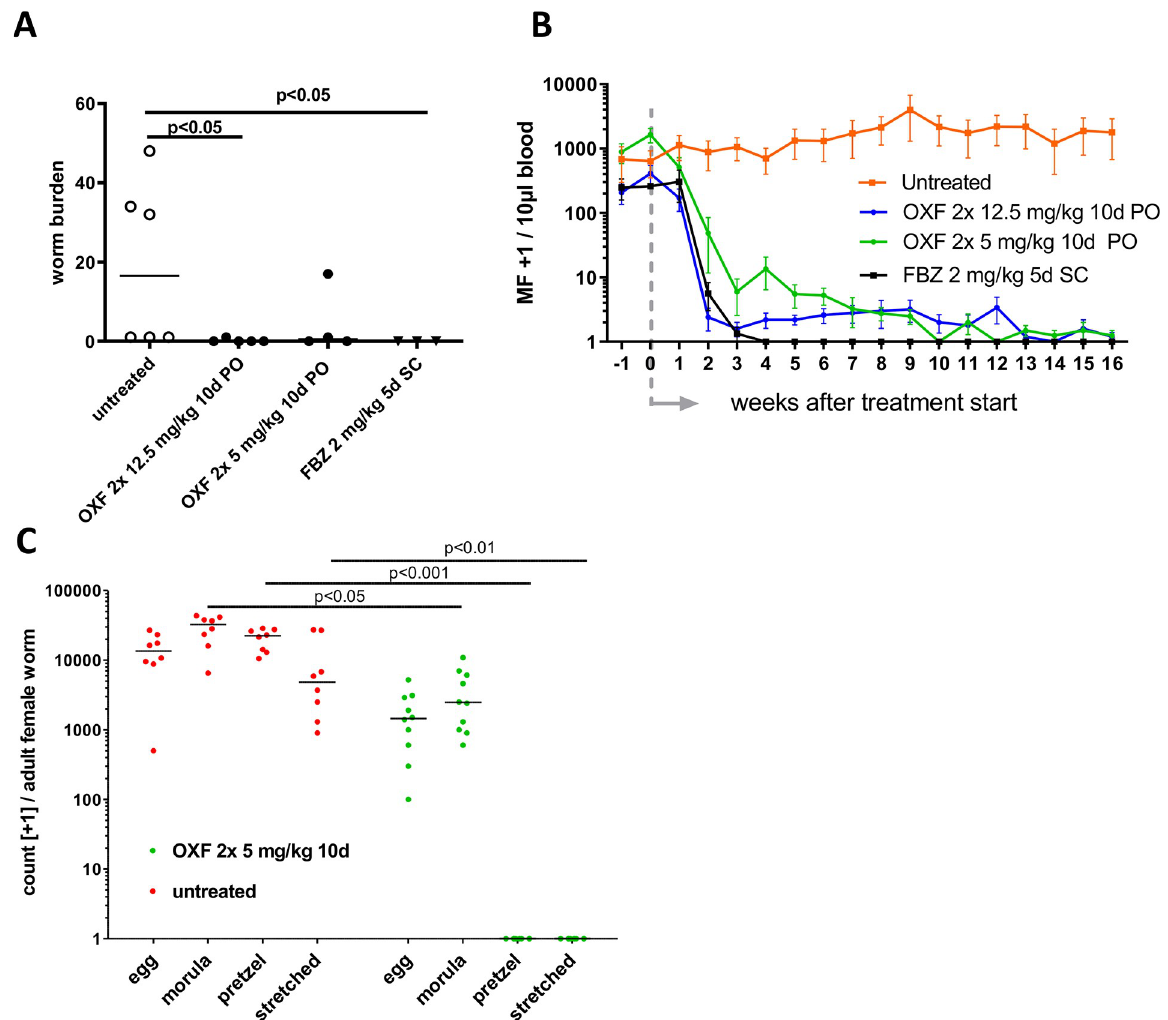
Fig 6. Oxfendazole treatment during patent L . sigmodontis infection demonstrates macrofilaricidal efficacy and inhibits embryogenesis in jirds. Microfilariae-positive jirds were treated 12 weeks post-infection (wpi) twice daily orally (PO) with 5 (n = 4) or 12.5 mg/kg (n = 5) oxfendazole (OXF) for a total of 10 consecutive days or subcutaneously with 2 mg/kg flubendazole (FBZ; n = 3) for 5 consecutive days. Untreated animals (n = 6) served as negative controls and necropsies were performed on all animals 16 weeks post-treatment (wpt). ( A ) L . sigmodontis adult worm burden at necropsy and ( B ) peripheral blood microfilariae levels over time. ( C ) Embryograms of female adult worms isolated from untreated (n = 8) and oxfendazole (n = 10) treated jirds (10 days, BID, 5 mg/kg) showing the total number of eggs, morulae, pretzel and stretched microfilariae per female worm. ( A, C ) Medians of one representative of two independent experiments are shown. ( B ) Means ± SEM of one representative of two independent are shown. ( A ) Kruskal-Wallis H-test: χ 2 = 10.62, df = 3, p = 0.004 followed by Dunn’s post-hoc test. ( B ) Two- way ANOVA: F (3, 252) = 24.29, p < 0.0001 followed by Dunnett’s multiple comparison test. p < 0.0001 for all treatment groups in comparison to untreated controls. ( C ) Kruskal-Wallis H-test: χ 2 = 60.16, df = 7, p < 0.0001 followed by Dunn’s multiple comparison